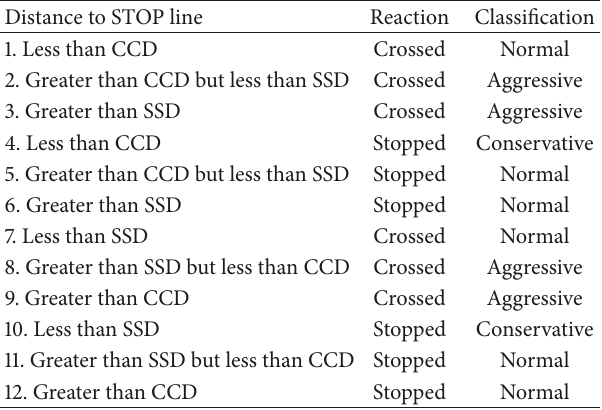
Table 1: Drivers 󸀠 process classification rules in case of yellow